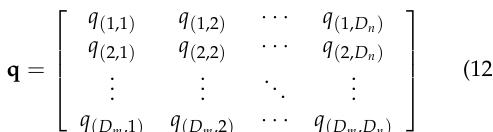
Fig. 3. Comparison of the tracking results of different algorithms on the OTB